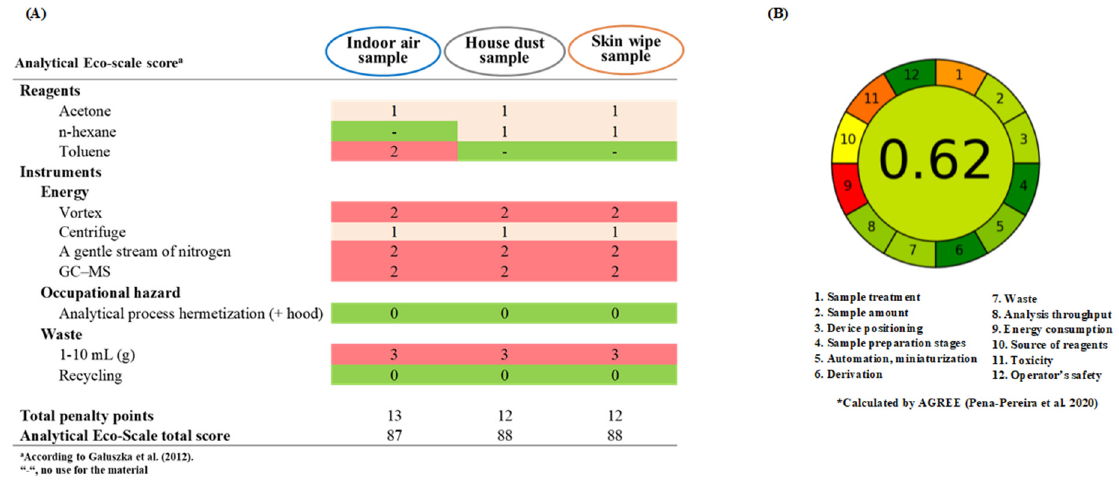
Figure 2. The Eco-scale score ( A ) and AGREE score ( B ) for the analytical procedures of OPFRs determinations in indoor air, house dust and skin wipe samples.